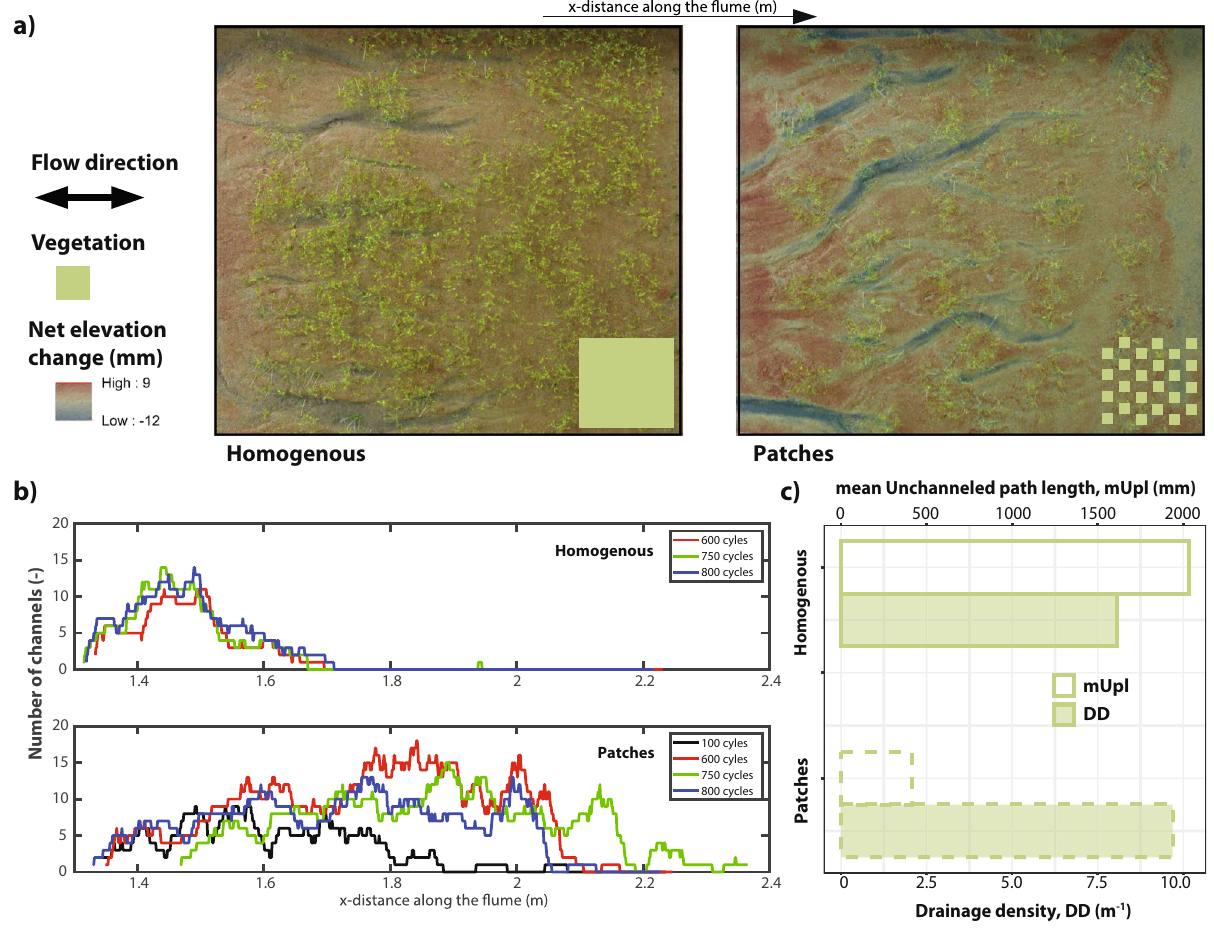
Fig. 4 Channel development in the laboratory experiment. a Sedimentation-erosion map of the vegetation scenarios; b number of channels over time (cycles represent time-scale of channel development) and distance along the fl ume; c drainage densities and mean unchanneled path length of the homogenous and patchy vegetation con fi